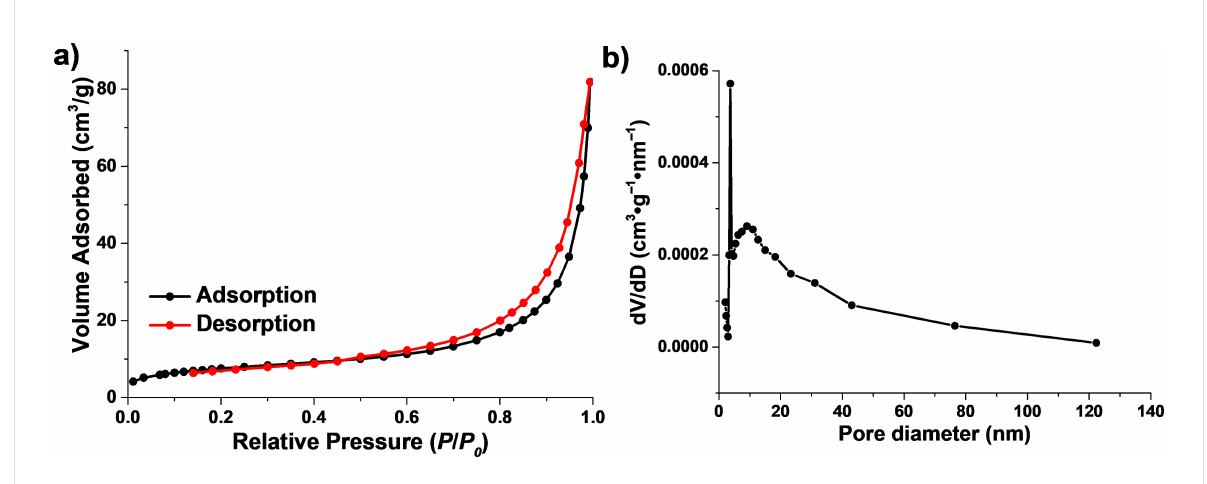
Figure 6: (a) N 2 adsorption − desorption isotherms and (b) the pore size distribution pattern analyzed from the adsorption isotherm of the hierarchical 70% − Bi 2 WO 6 /TiO 2 -NT